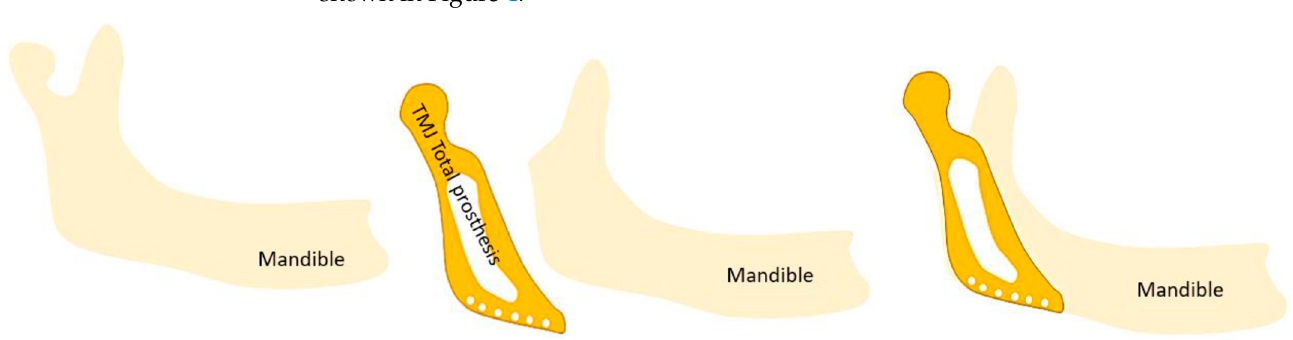
Figure 4. Schematic representation of a TMJ total prosthesis.